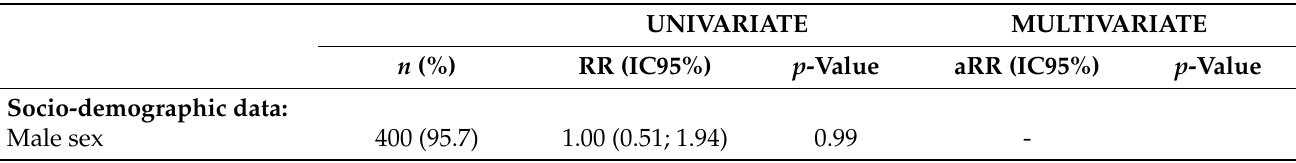
Table 3. Factors associated with high MCN